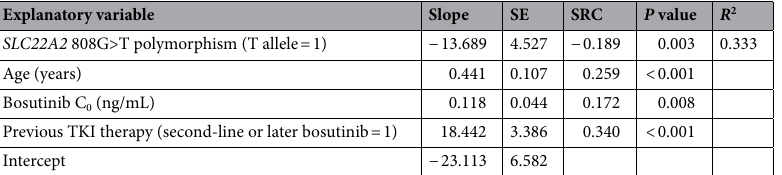
Table 4. Stepwise multiple regression analysis of explanatory variables for the change rate of serum creatinine. SE standard error, SRC standardized regression coefficient, C 0 trough plasma concentration, TKI tyrosine kinase